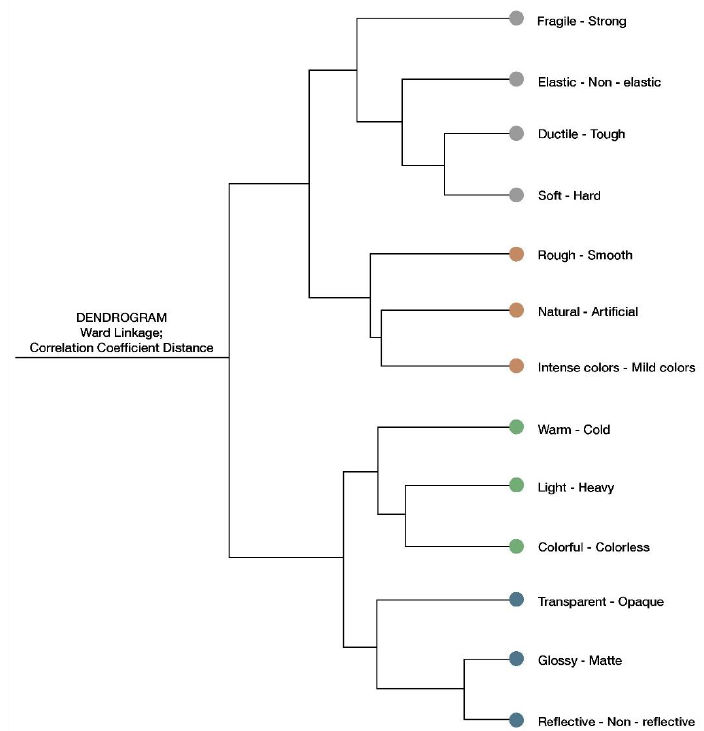
Figure 11. A hierarchical cluster analysis of the sensory descriptors performed using the Ward linkage method.